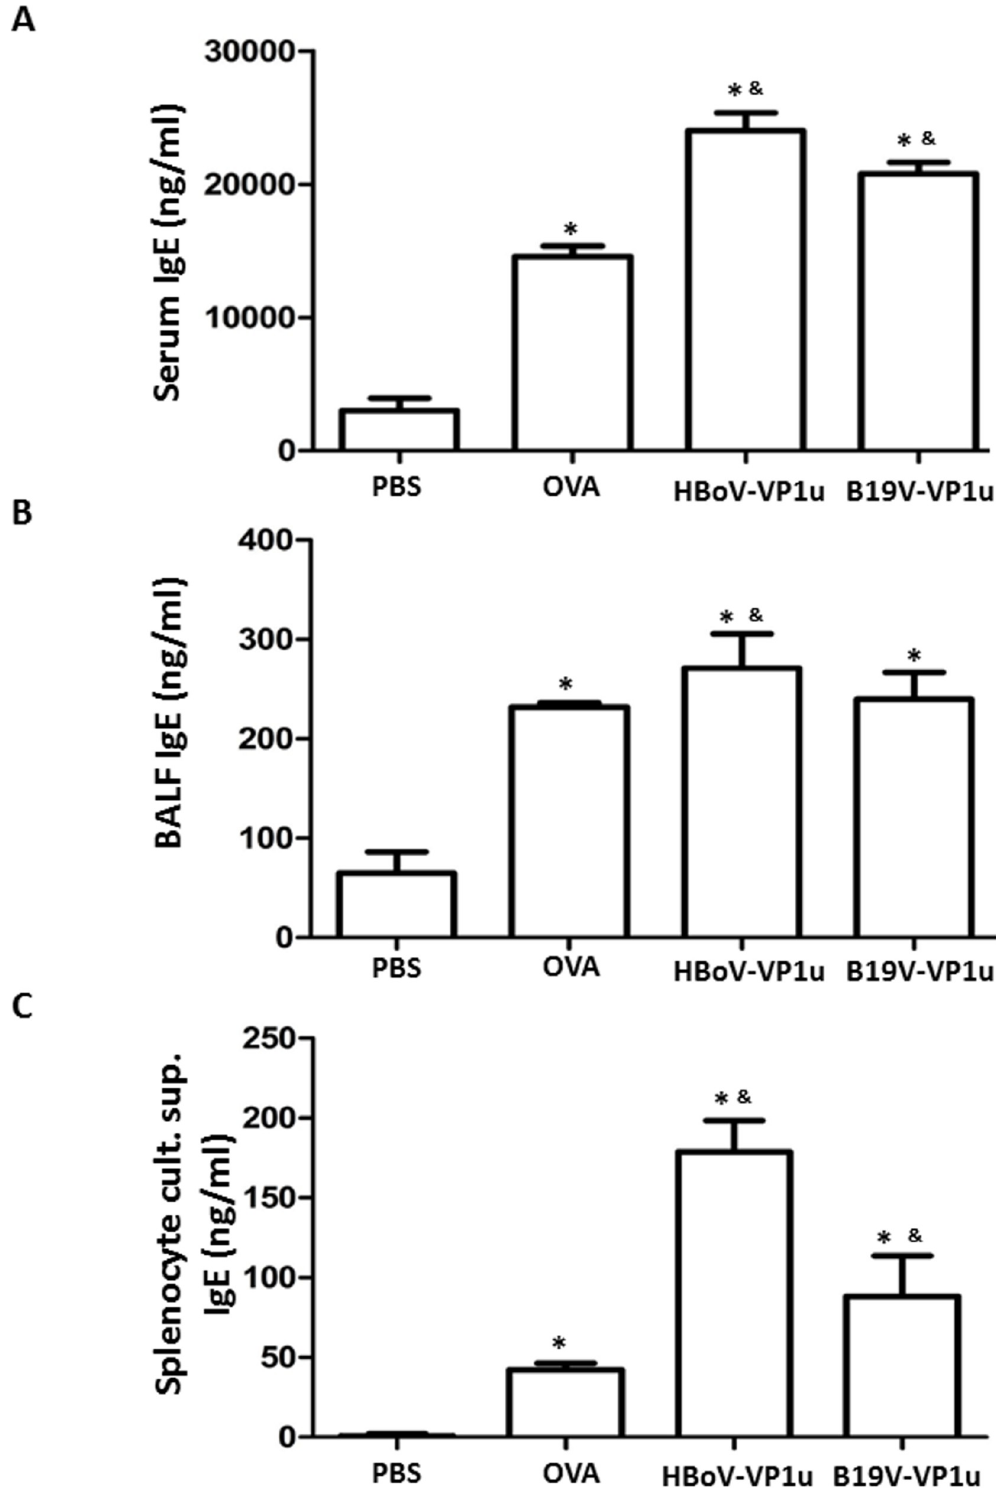
Fig 2. The level of IgE. The specific anti-OVA IgE was measured in (A) serum, (B) BALF and (C) supernatant of splenocytes culture in mice from PBS, OVA, HBoV-VP1u and B19V-VP1u groups. Values are mean ± SD. Similar results were observed in three repeated experiments. � and & indicate significant difference, p < 0.05, relative to PBS and OVA groups, respectively. (n = 5 for each group). https://doi.org/10.1371/journal.pone.0216799.g002 PLOS ONE | https://doi.org/10.1371/journal.pone.0216799 May 14,